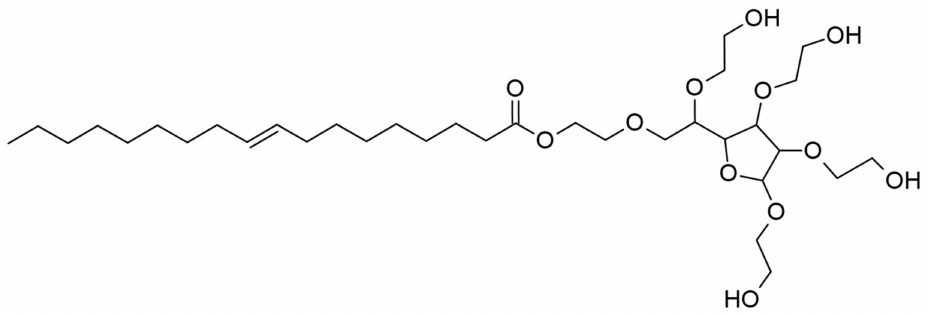
Figure 11. Chemical structure of polysorbate